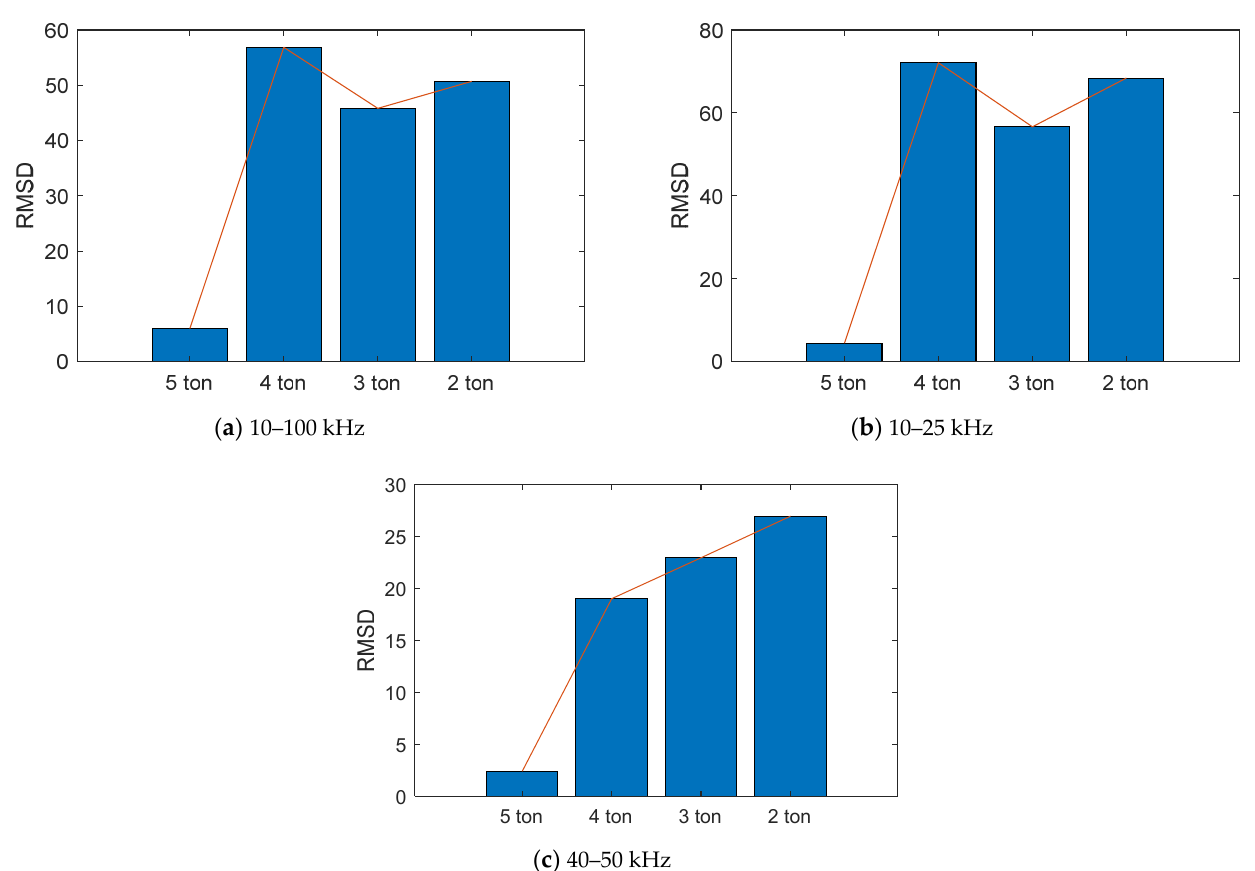
Figure 11. The RMSD index of the electromechanical impedance of the washer-type PZT interface. Next, the impedance response of the two-point mount PZT interface was